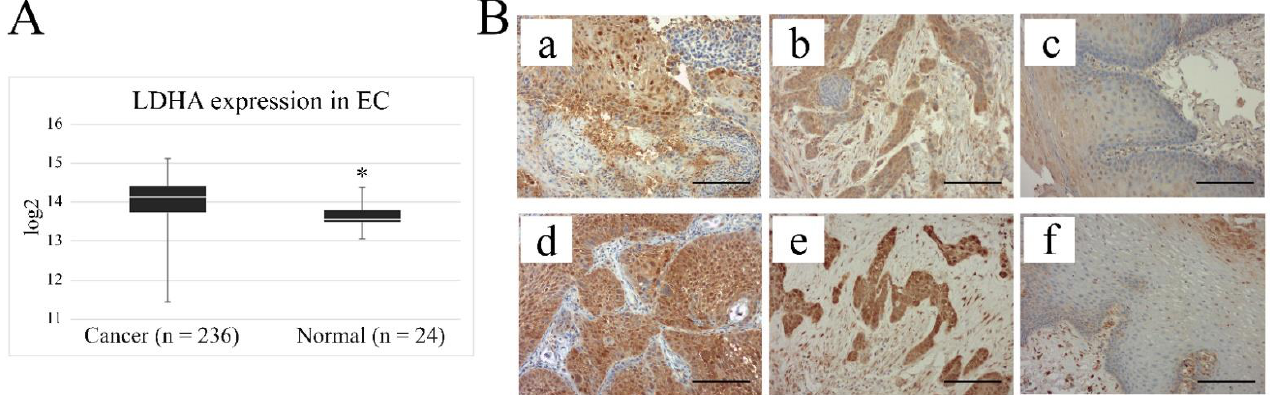
Figure 1. Expression levels of LDHA in cancerous and normal esophageal tissues. ( A ) Comparative analysis of LDHA gene expression in normal (n = 24) and tumor (n = 236) esophageal tissues based on data downloaded from gent2 database. Results show significantly higher levels of LDHA mRNA in tumors, compared to the control group. ( B ) Representative examples of LDHA localization in histologically normal epithelium taken from the border of resection from patients operated for esophageal cancer ( c , f ), and in ESCC tissues ( a , d ) and EAC tissues ( b , e ), visualized by immunohistochemical (IHC) method (magnification: ×200). Scale bars, 100 µm. * p < 0.005.